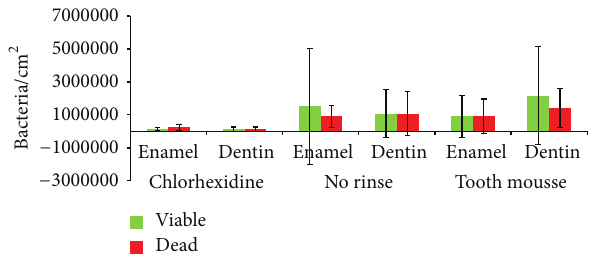
Figure 2: DAPI staining for detection of total amount of bacteria after application of GC Tooth mousse, rinse with chlorhexidine, or no rinse. After 1 min of pellicle formation, GC Tooth mousse was appliedandrinseswithchlorhexidine(8 mL/1min)wereperformed, respectively. The enamel and dentin samples were carried overnight for 8 h in situ fixed on individual upper jaw splints. MV ± SD, 𝑛 = 8 subjects, two samples per subject and subgroup.